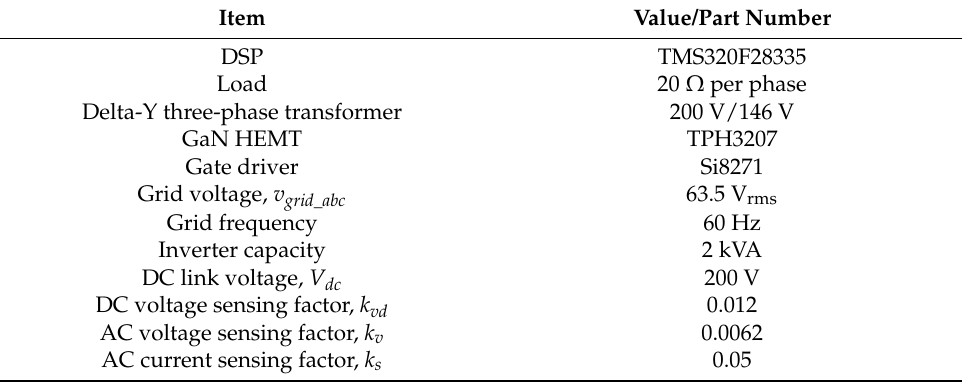
Table 4. Specifications and parameters of hardware